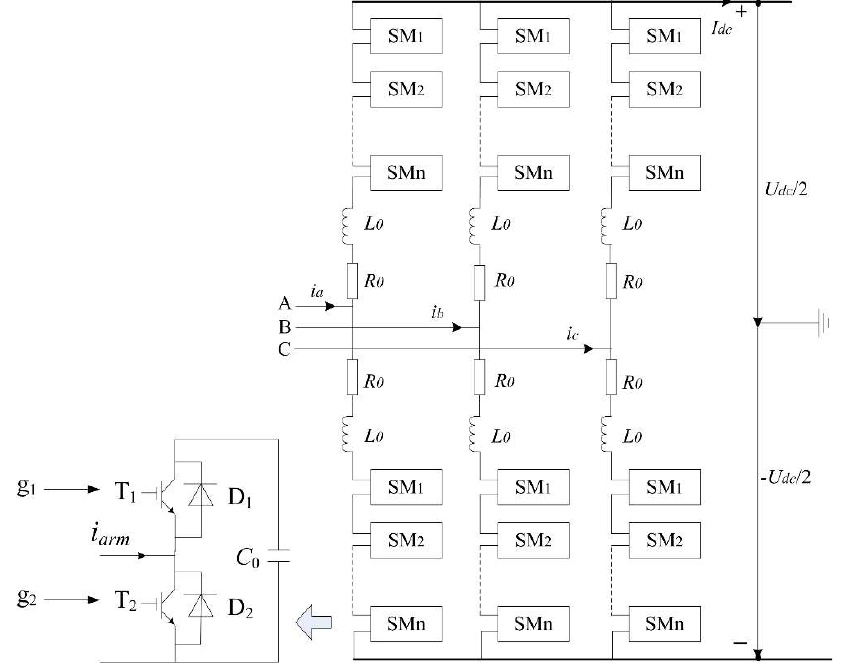
Figure 1. Three-phase MMC topology